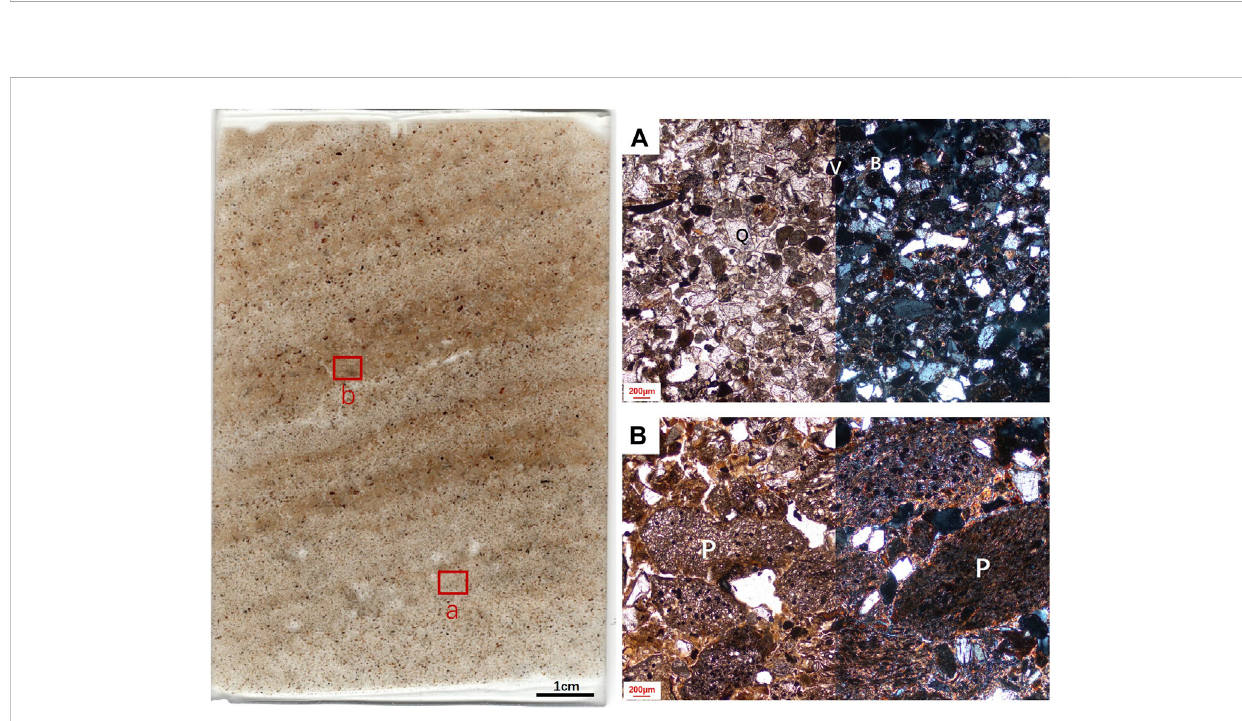
FIGURE 5 Scan of the thin section from block sample DD4. Alternations of dark brown tephra layers and light brown fl uvial sands can be seen. (A) fi ne to medium sandsize,sub-rounded fl uvialsands; widelyfoundvolcanic glassshow igneous lithologies (PPLandXPL), V:volcanic glass;B:bitotite; Q:quartz. (B) tephra layer, with a pellicular to intergrain micro-aggregate structure (PPL and XPL), P: